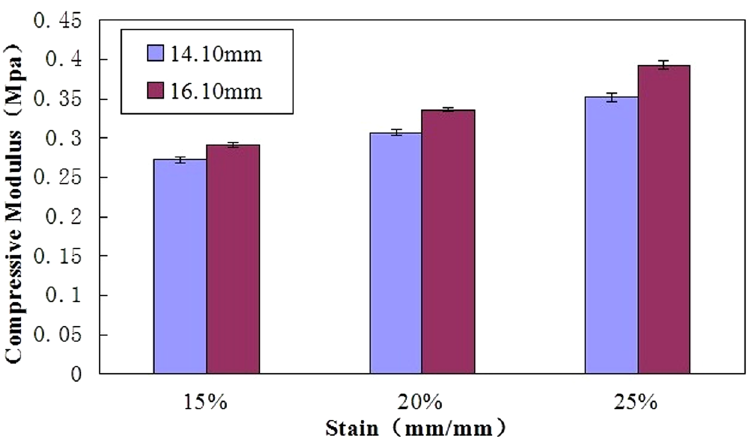
Figure 2. The tangent modulus values in 16.10 mm group at 15%, 20% and 25% strain were 0.07-fold, 0.10-fold, 0.11-fold higher than that of the 14.10 mm group. The unconfined compression modulus increases as the strain magnitude